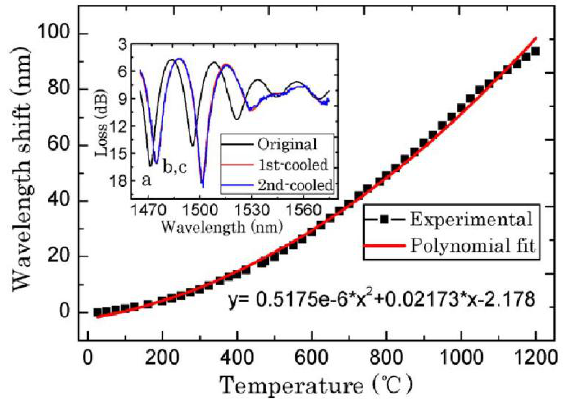
Figure 10. The temperature sensitivity of micro-cavities based MZI as shown in Figure 9(b). The inset is the transmission spectra ( a ) before heating at 25 °C, ( b ) and ( c ) the first time and second time of cooling down to 25 °C,